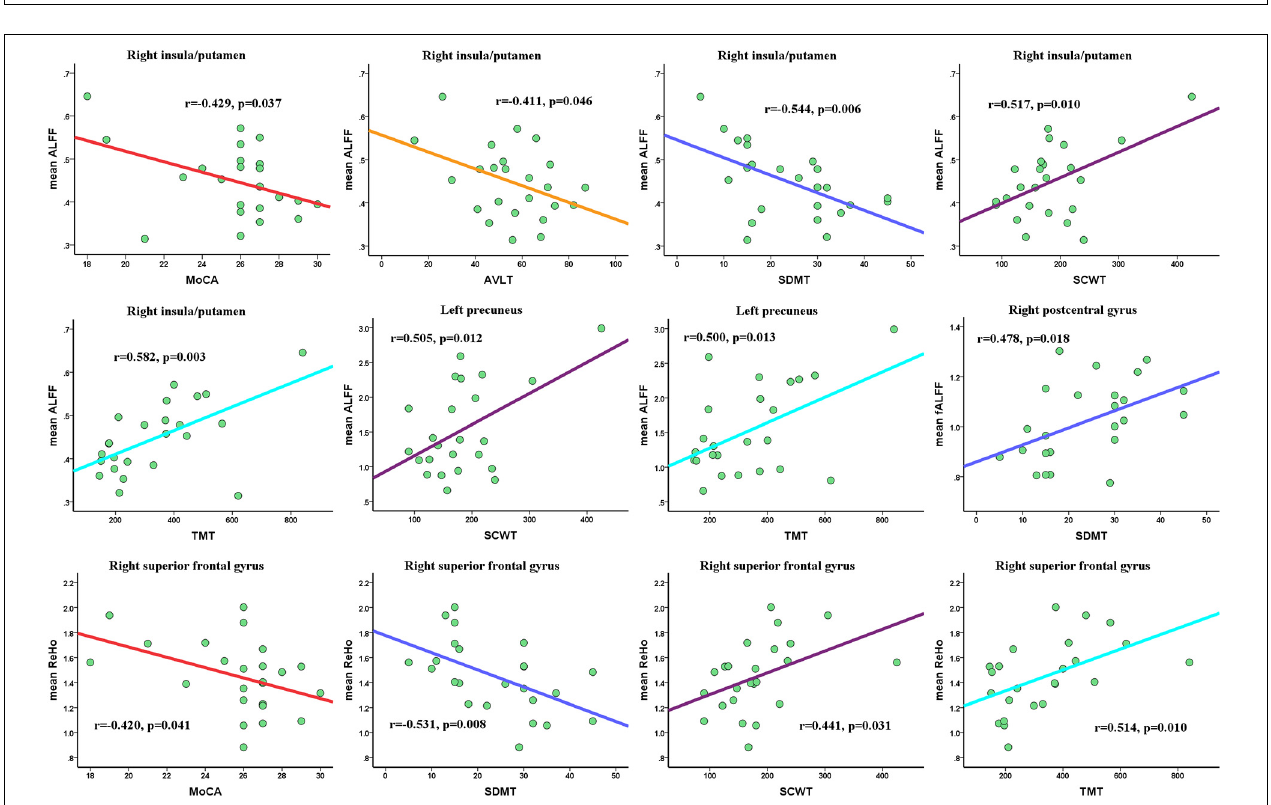
FIGURE 4 | ROC curve for altered brain clusters relevant to (A) ALFF/fALFF and (B) ReHo that distinguish CSVD-c patients from controls. ALFF, amplitude of low-frequency fluctuation; fALFF, fractional ALFF; ReHo, regional homogeneity; SMA, supplementary motor area; SFG, superior frontal gyrus.